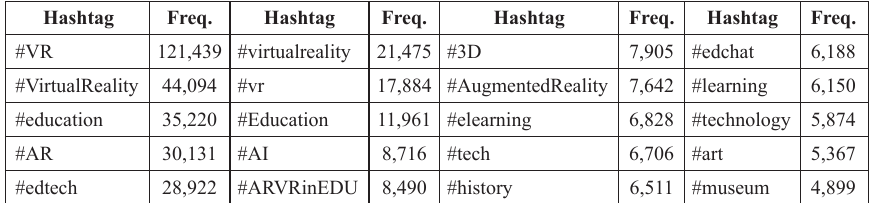
Table 4. Frequency of the top-20 most commonly used hashtags within the